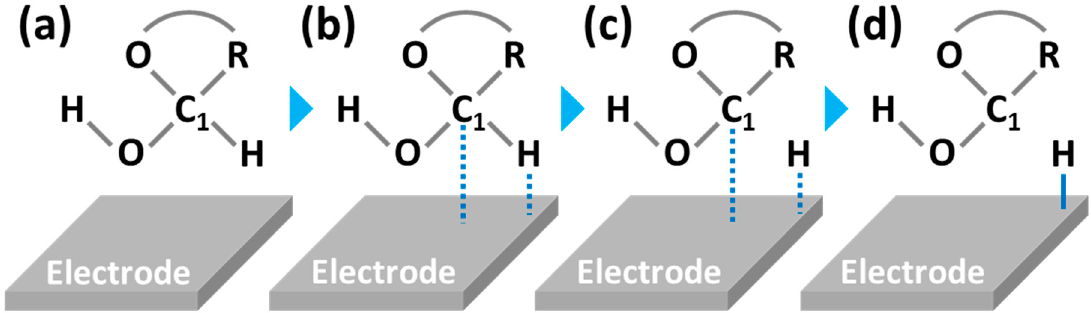
Figure 4. An illustration for the “activated chemisorption model (first model for the non-enzymatic glucose sensor)”, which includes ( a ) adsorption, ( b ) bond formation, ( c ) bond breaking, and ( d ) desorption processes between the glucose molecule and the electrode surface. (C 1 : hemiacetalic carbon atom; R: the remaining parts of the glucose molecule; dotted lines: relatively weak bonding; solid lines: relatively strong bonding).